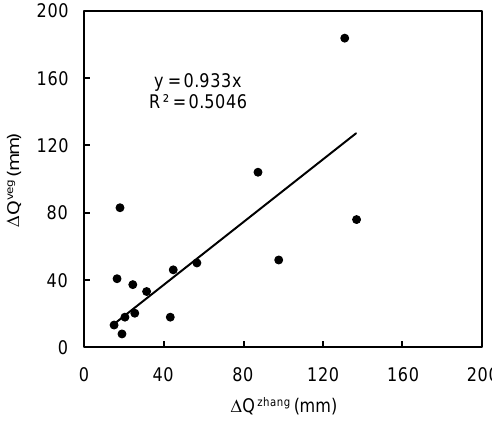
Fig. 6. Comparison between estimates of mean annual stream- Figure 6. Comparison between estimates of mean annual streamflow reductions using FCFC 2 flow reductions using FCFC ( 1Q zhang ) and the time-trend analysis method ( 1Q veg (  Q zhang ) and the time-trend analysis method (  Q veg ). 3